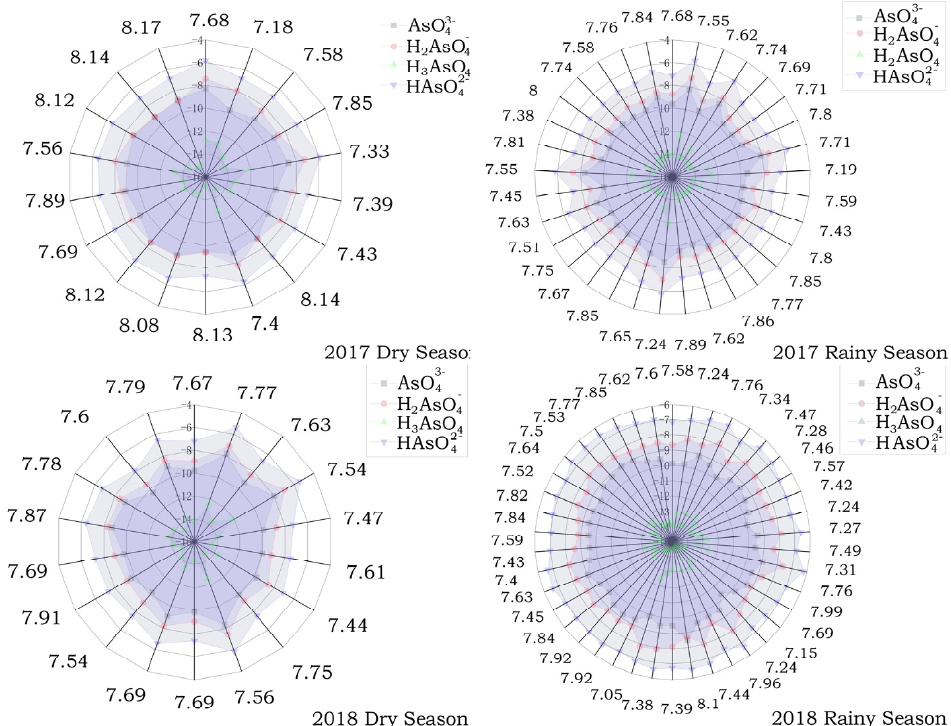
Figure 7. Logarithmic values of the activities of the possible compounds of As generated by the simulations.